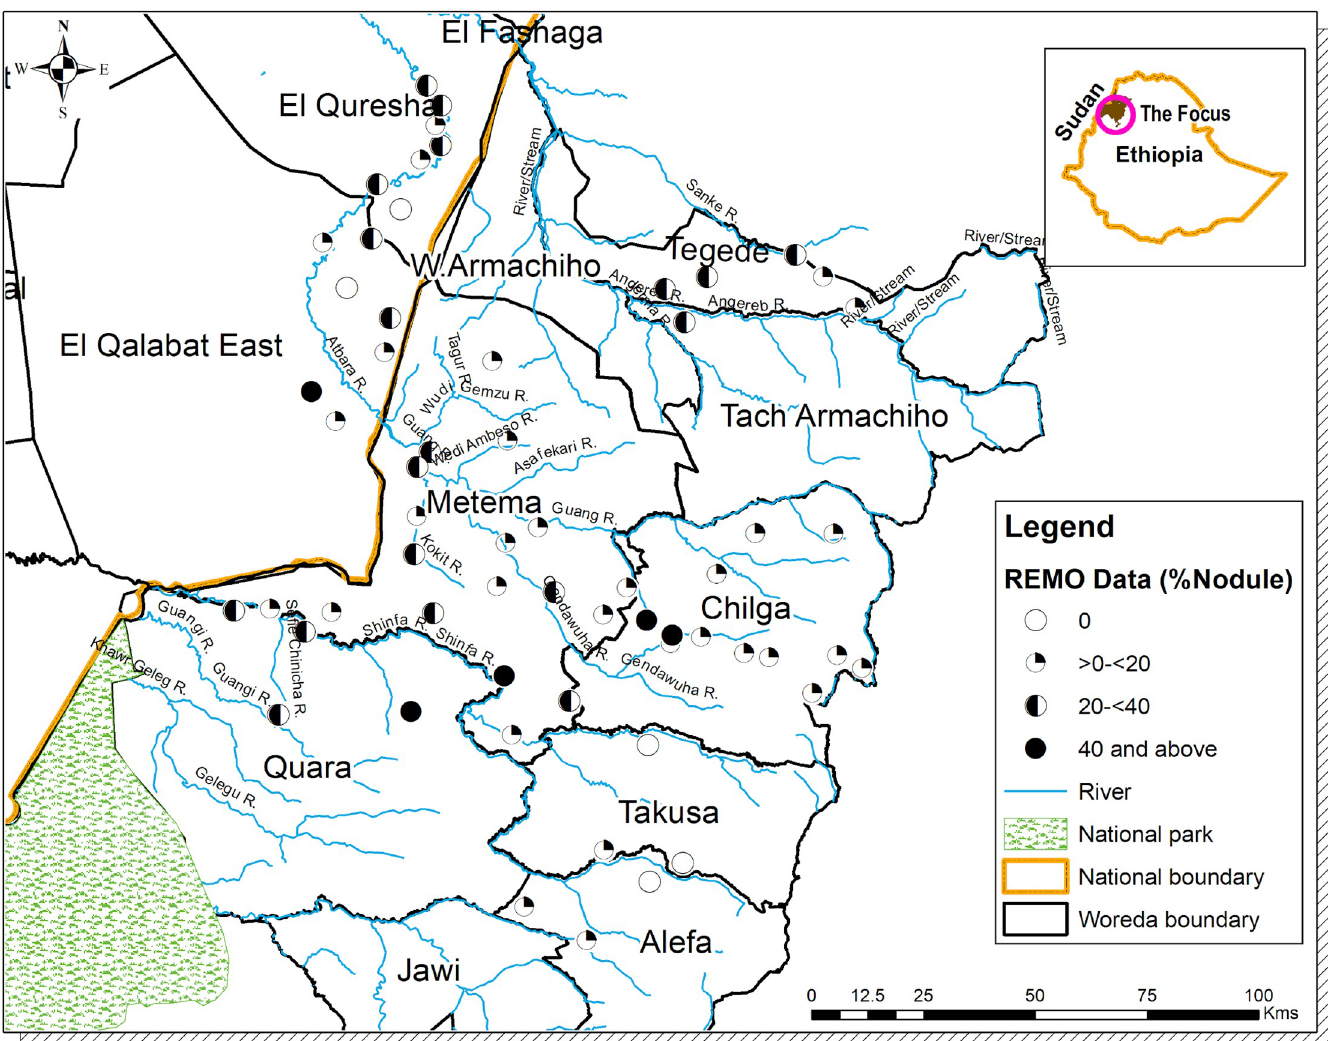
Fig 1. Baseline Rapid Epidemiological Mapping of Onchocerciasis (REMO) conducted in and around the Galabat- Metema Onchocerciasis focus (based of 1998– 2011 nodule prevalence surveys, see Table 1. Not copyrighted, and was created in